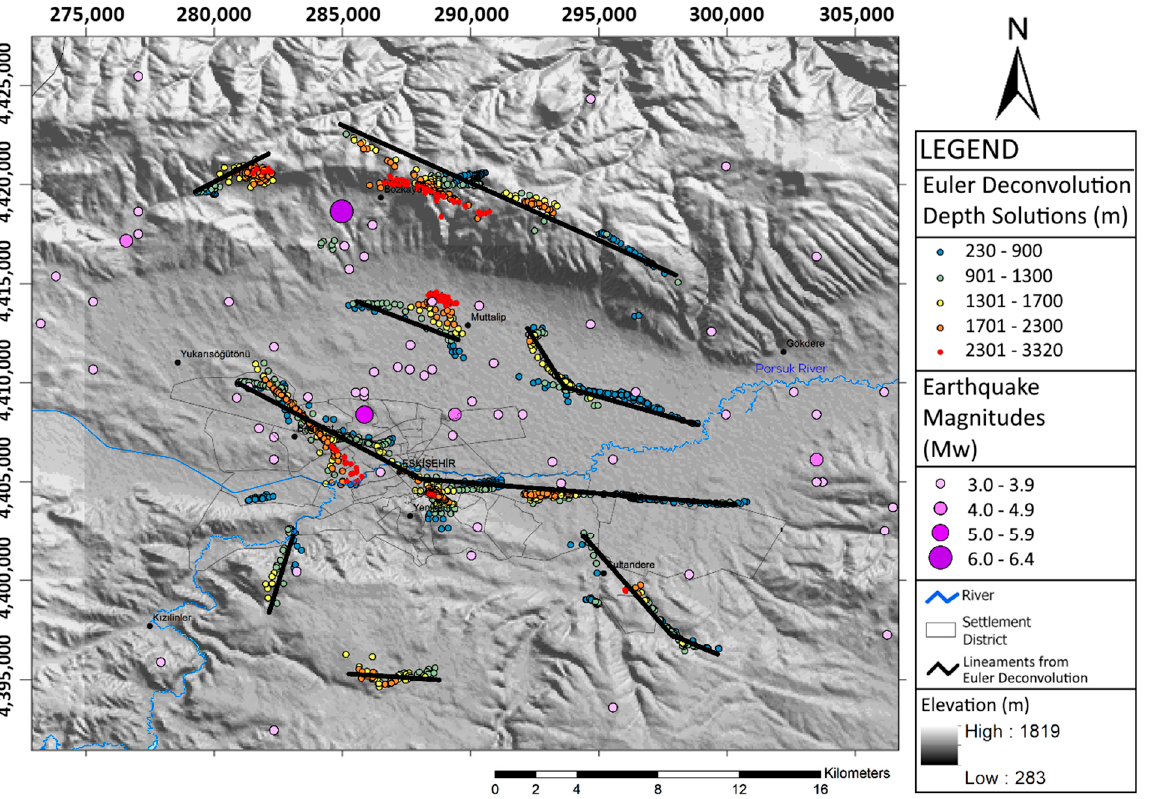
Figure 6. ED solutions for “ N = 0” superimposed on topography map. ED depth solutions range from 230 m to 3320 m which are highly compatible with spectral analysis solutions. The sizes of the purple circles show the earthquake locations according to their magnitude. (Datum: WGS84 UTM Zone 36 N).